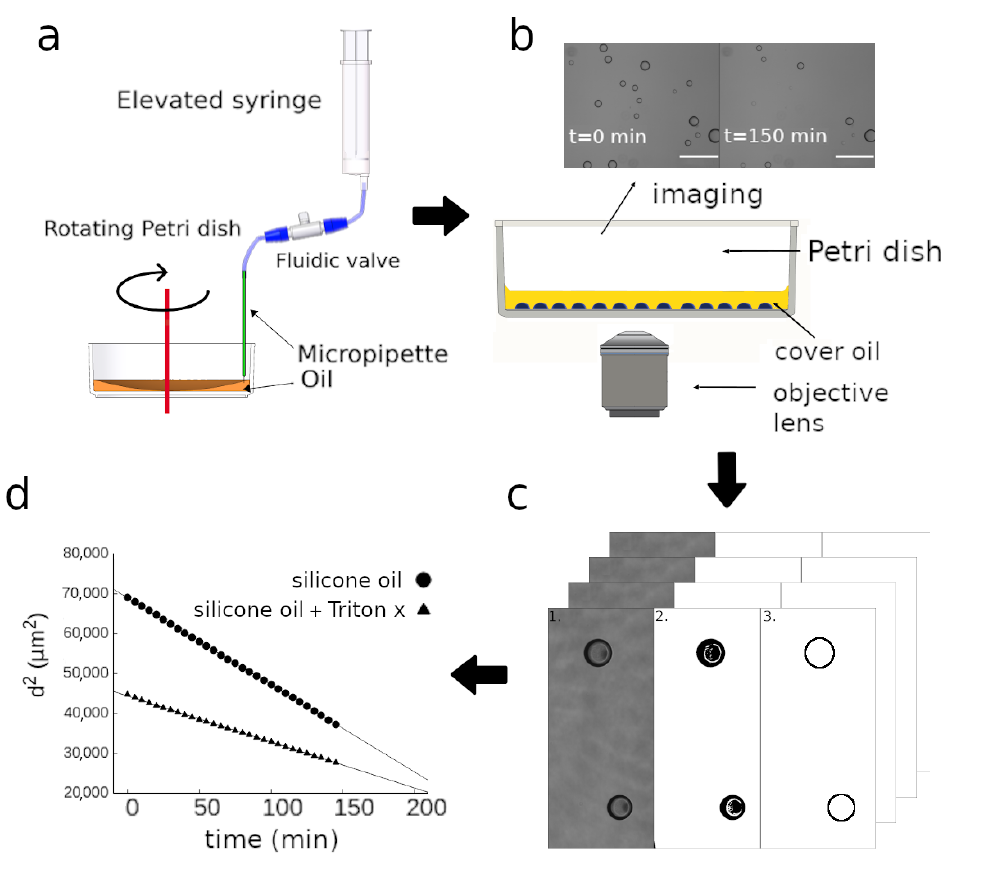
Figure 1. The workflow of droplet diameter measurements. ( a ): The droplets are generated by a water filled micropipette immersed in a rotating Petri dish containing oil. ( b ): The Petri dish with the w/o emulsion is placed on an inverted microscope and images are taken in time-lapse mode. Scale bars indicate 100µm. ( c ): Image stacks are segmented to detect and track the droplets. ( d ): Diameter of droplets is automatically measured to plot the curves of droplet